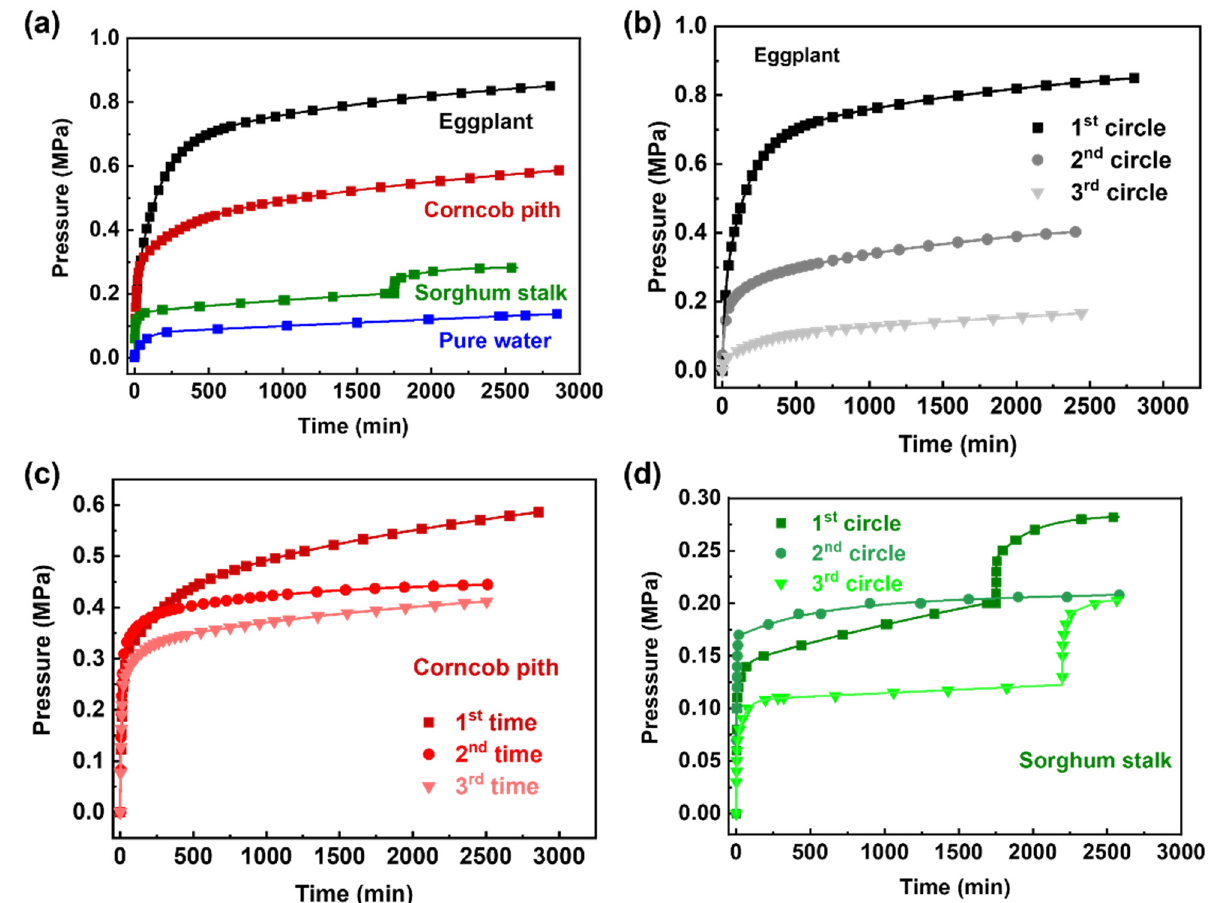
Figure 5. ( a ) Methane sorption kinetics for bulk water, waxy corncob pith, sorghum stalk, and eggplant; ( b – d ) are the curves of methane gas adsorption from eggplant, corncob pith, and sorghum stalk in three cycles, respectively.